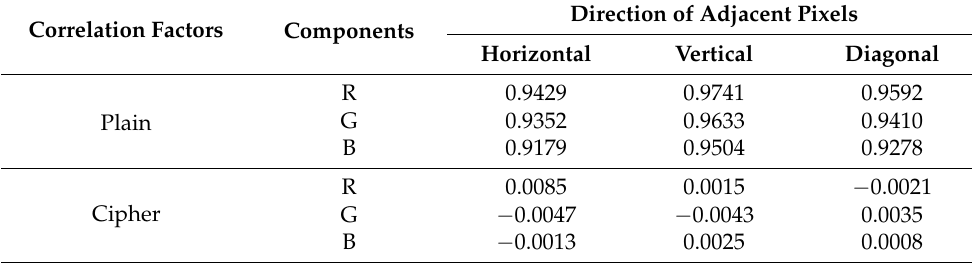
the plain and cipher images. Table 3. The various calculated correlation factors on Lena